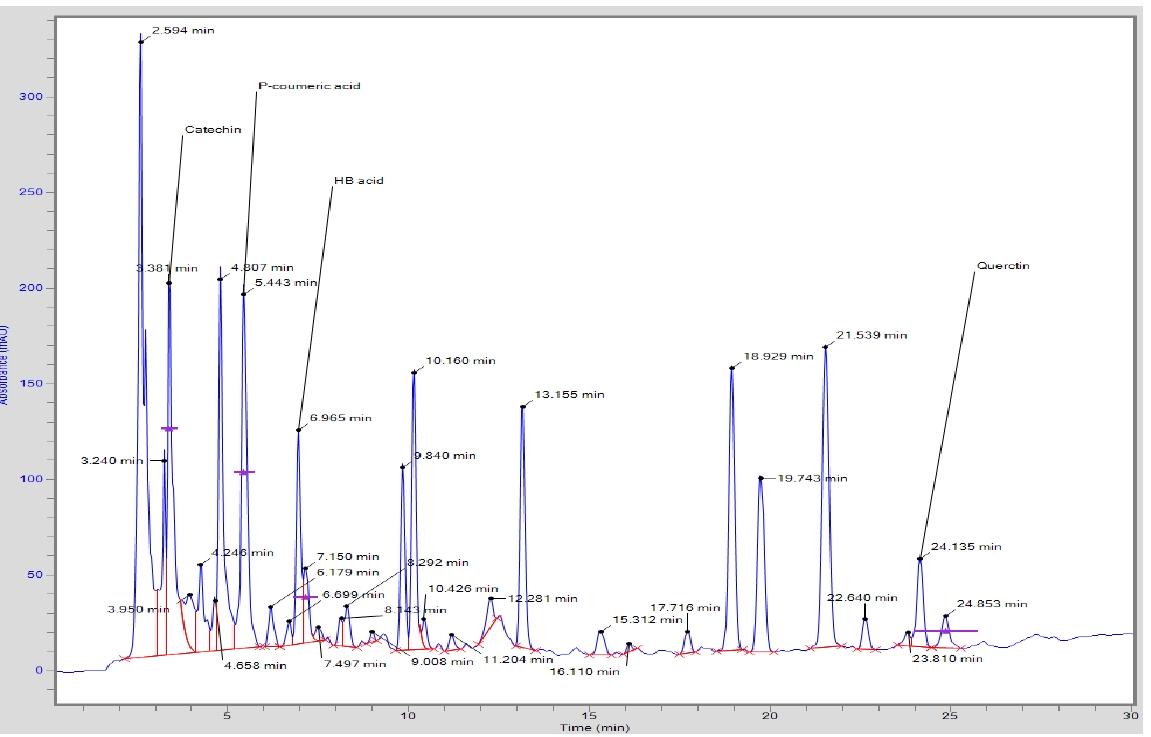
Figure 1. Typical HPLC chromatogram showing the separation of polyphenols from star anise ex ‐ tracts.